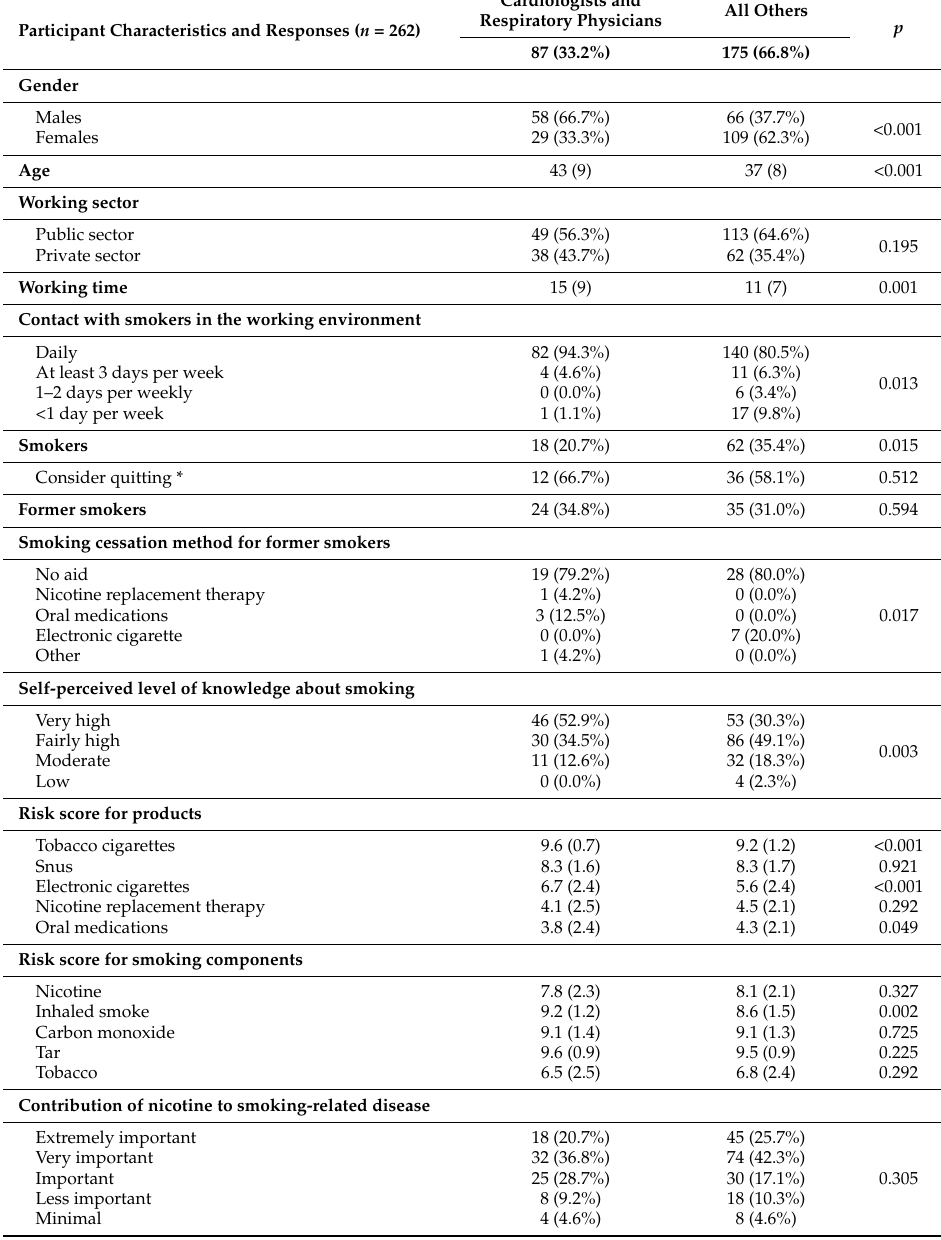
Table 4. Survey responses of cardiologists and respiratory physicians compared to all other